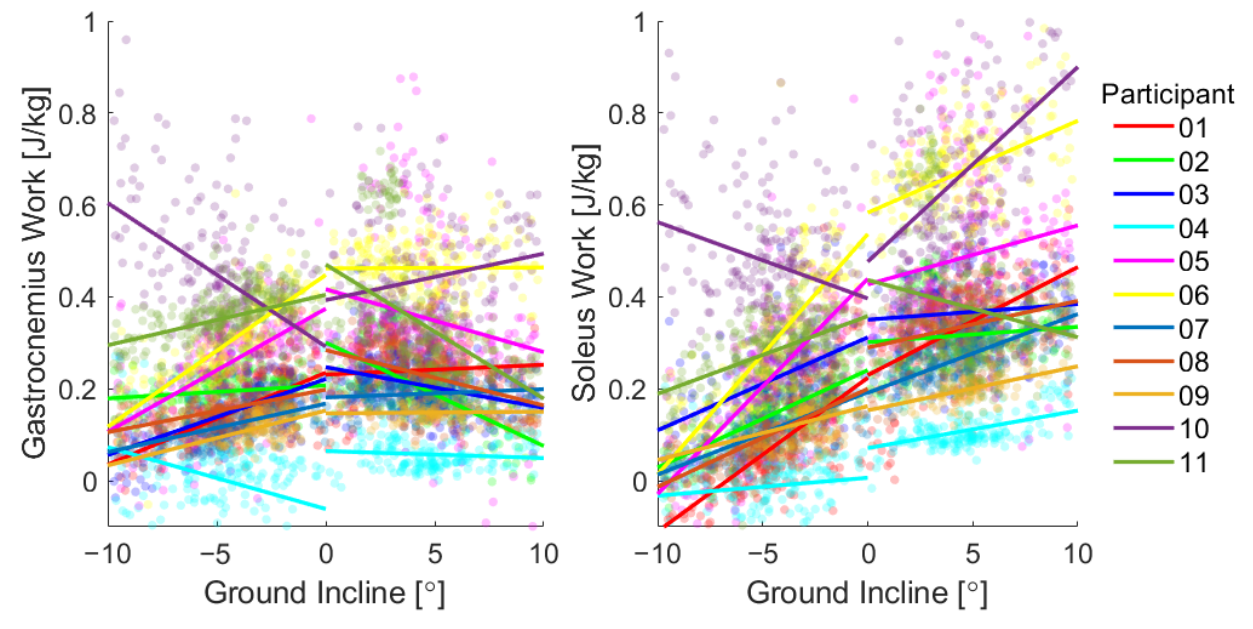
Figure A5. Estimated net gastrocnemius work was less sensitive to incline, whereas net soleus work for each participant generally increased with ground incline (observe positive slopes for all but two lines).